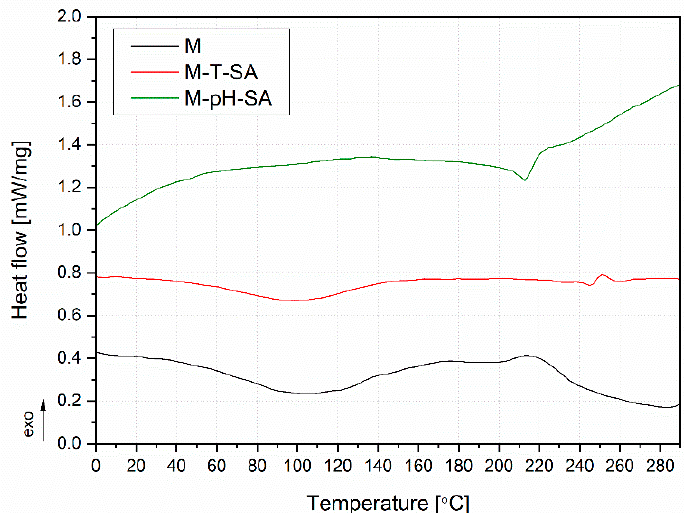
Figure 9. DSC thermograms of the basic matrix (M) and systems with thermo/pH-sensitive nanocar- riers and salicylic acid.